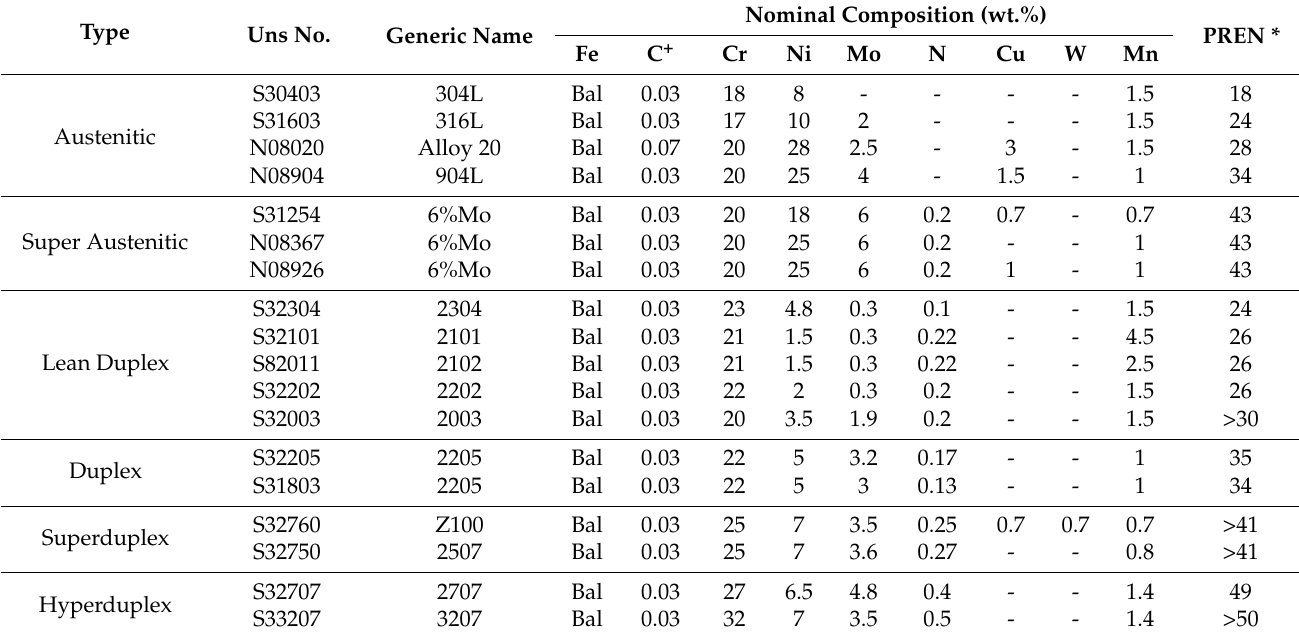
Table 1. Nominal Compositions of some commonly used wrought stainless steels. PREN: Pitting Resistance Equiva- lent Number.